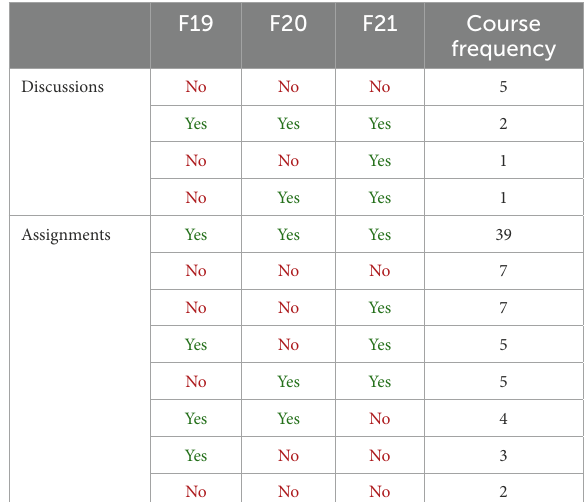
TABLE 11 The patterns of use of discussions and assignments features in Canvas for courses that mention discussions and assignments in their course descriptions per